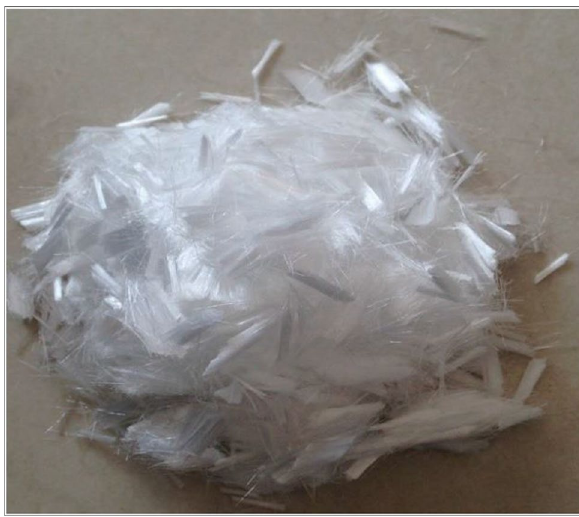
Fig. 3 Shape of the polypropylene